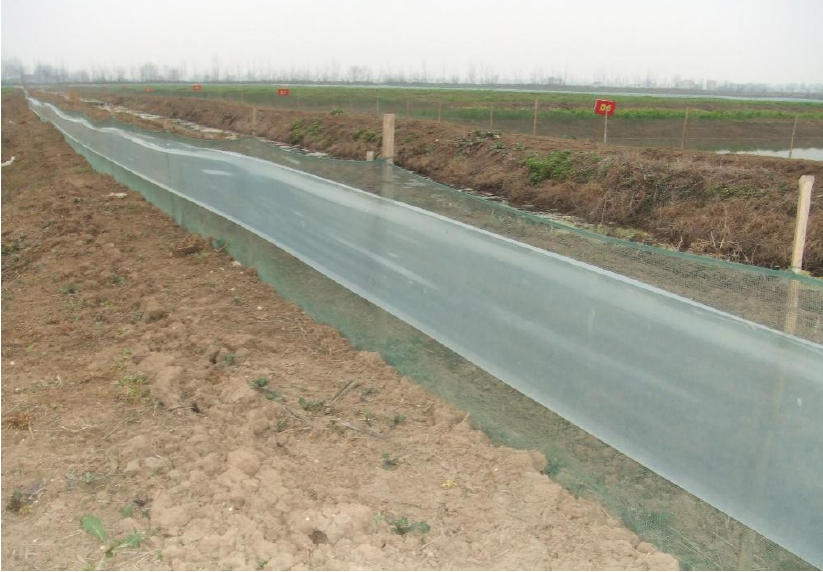
Figure 4. A plastic fence for the prevention of escaping crabs in the rice–crab coculture system.